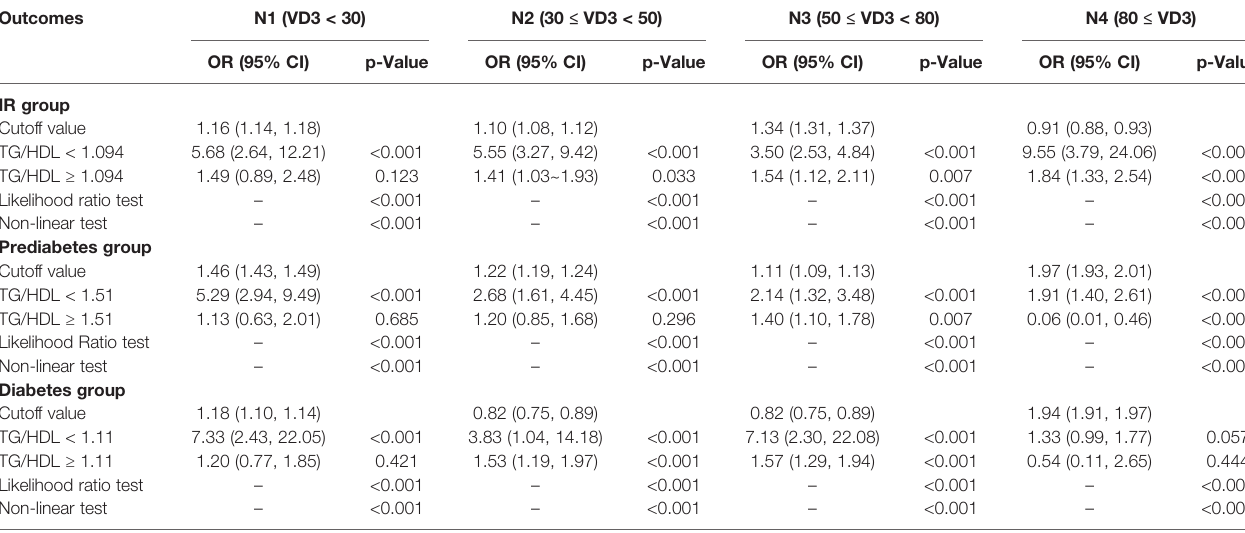
TABLE 4 | Threshold analysis of TG/HDL on the incident of IR, IGT, and DM in the NHANES study, 2009 –